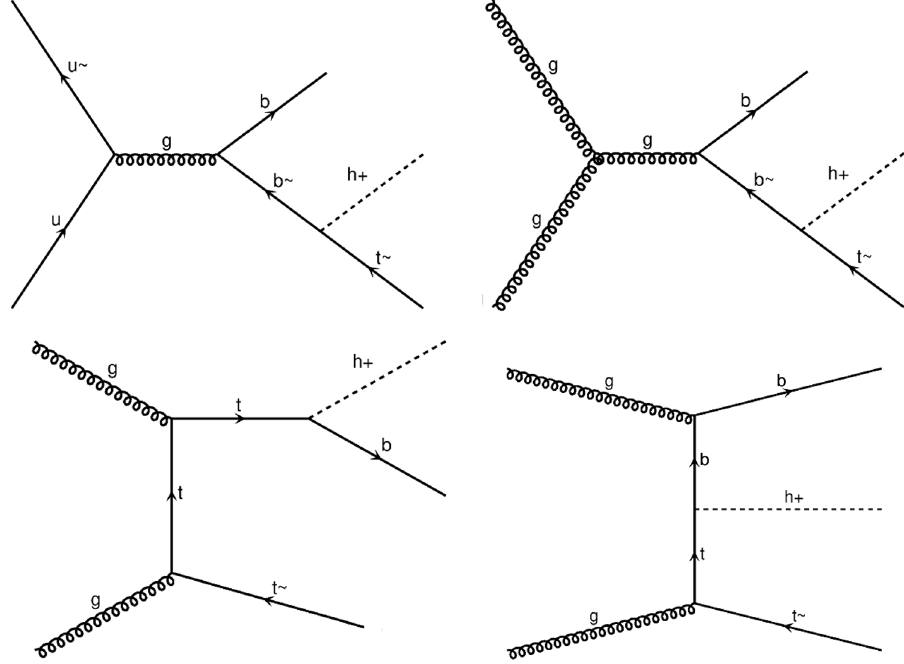
Figure 5 . A selection of signal Feynman